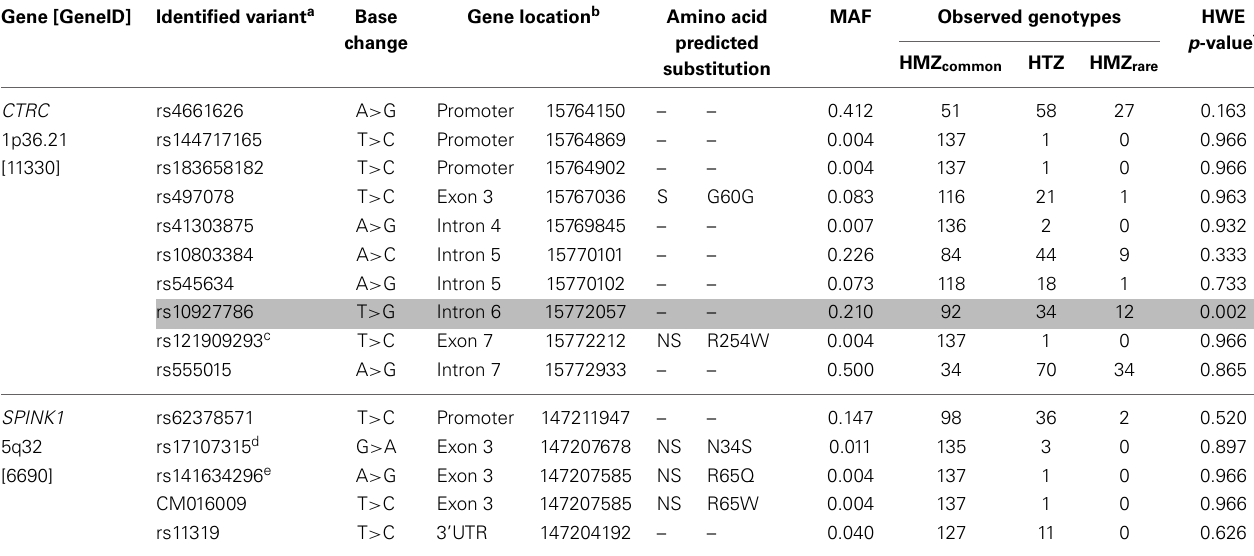
Table 2 | Genetic Characteristics of the CTRC and SPINK1 Variants Identified.